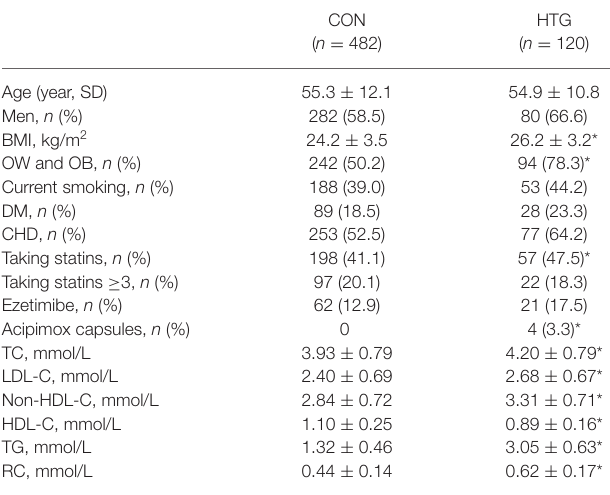
TABLE 1 | Baseline characteristics of the study